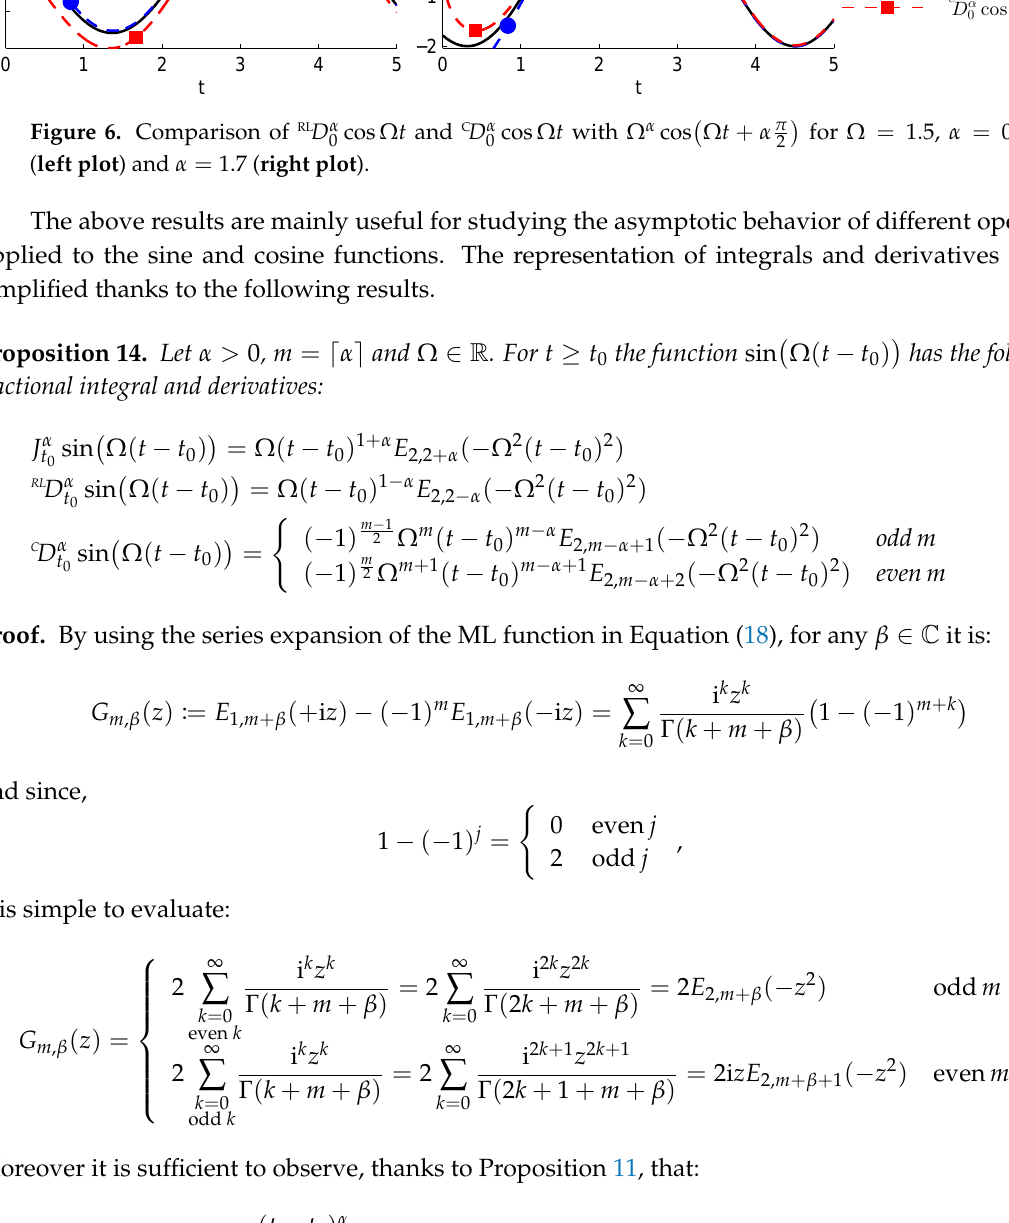
cos Ω t with Ω α cos 0